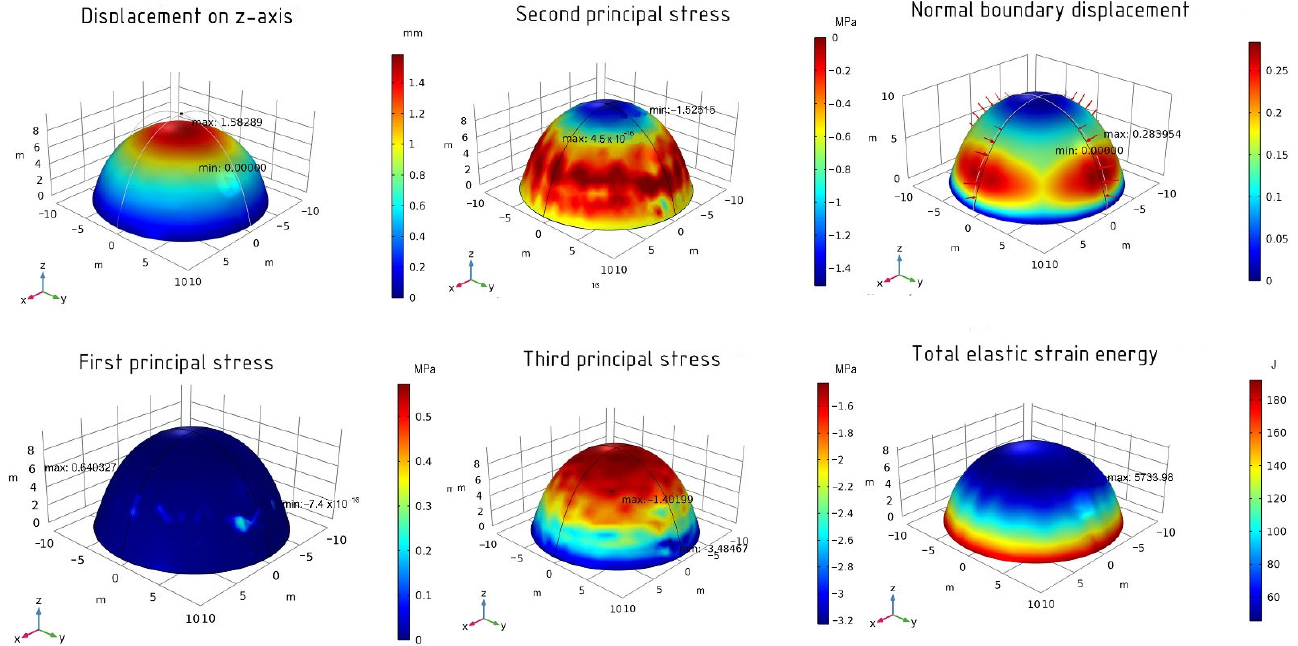
Figure 15. The results of the optimized shell using the IPOPT method. For the optimized shell on the z ‐ axis, the maximum displacement value is 1.58 mm. The first principal stress has he following values: − 7.4 × 10 − 16 MPa (minimum) and 0.64 MPa (maximum). For the second principal stress, the minimum value is − 1.53 MPa and the maximum value is 4.5 × 10 − 16 MPa. The values of the third principal stress are − 3.48 MPa (minimum) and − 1.40 MPa (maximum). The normal boundary displacement is 28% and the total elastic energy is 5733.98 J. The results are shown in Figure 16.